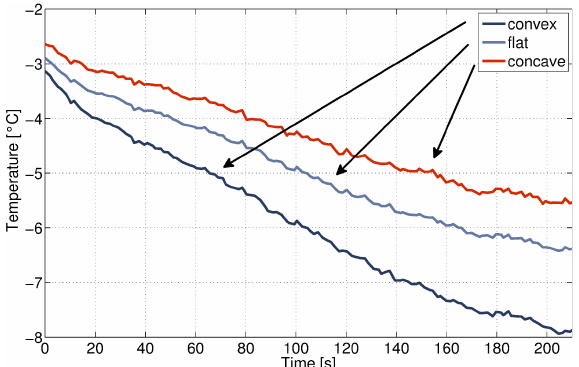
Fig. 7. Thermal images of the specimen shown in Fig. 1a after ap- proximately 4min, (a) inside and (b) outside the cold lab. Colorbar in ◦ C.